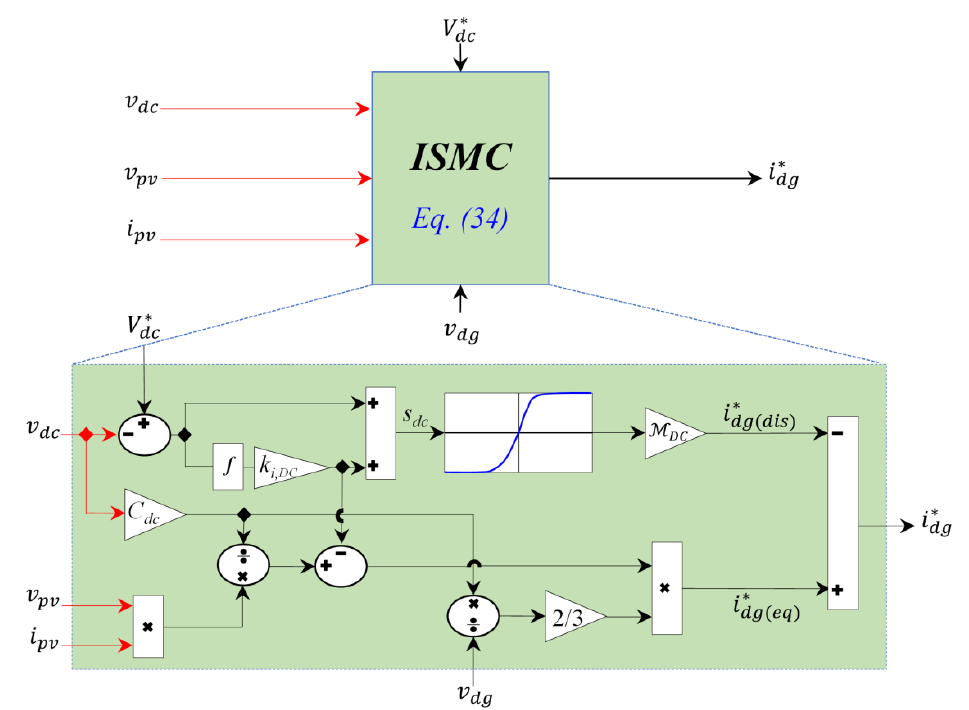
Figure 8. Block diagram of the proposed DC-Link voltage controller based on ISMC theory.